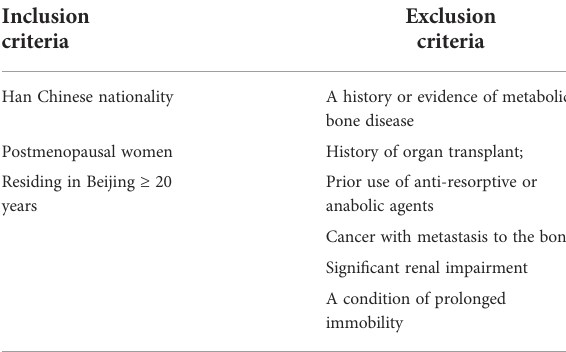
TABLE 1 Inclusion and exclusion criteria for this study.